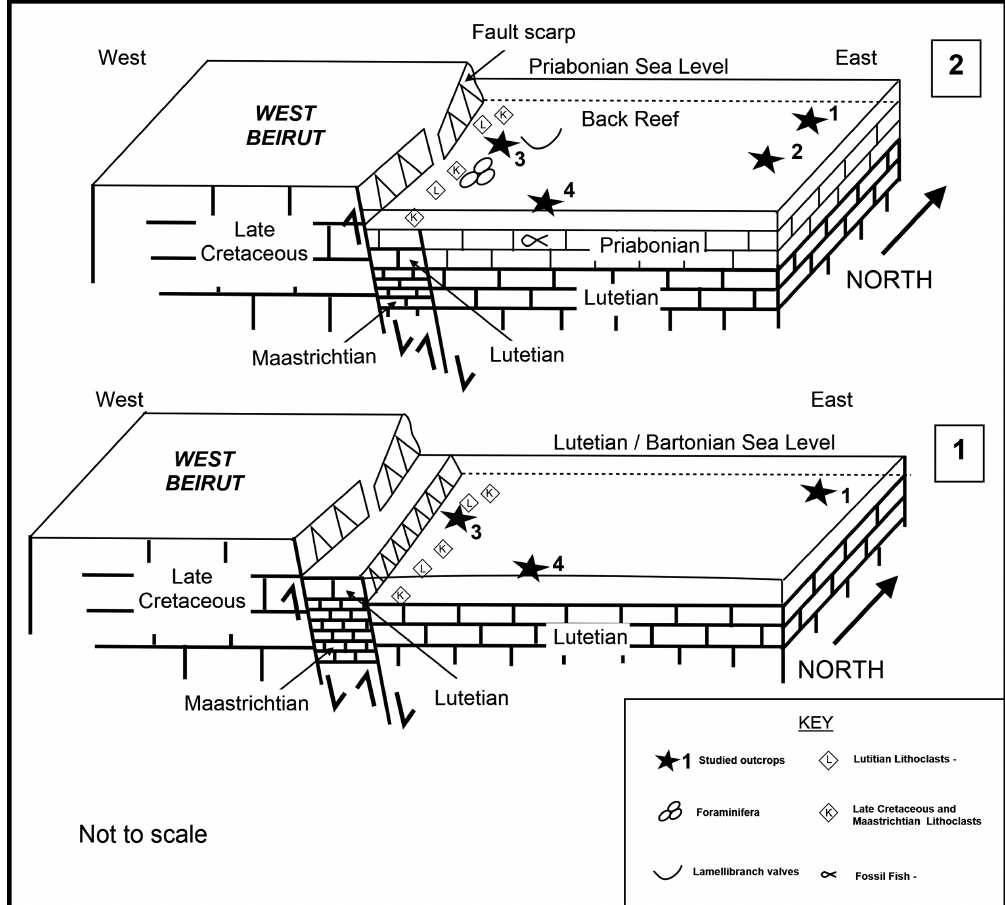
Diagram (1) shows an old elevated Lutetian/Bartonian Ns composite faulted western block and the Lutetian/ Bartonian shoreline by its eastern side. Diagram (2) shows the inner platform shallow water sediments during the early Priabonian time in the backreef waters of the western structural